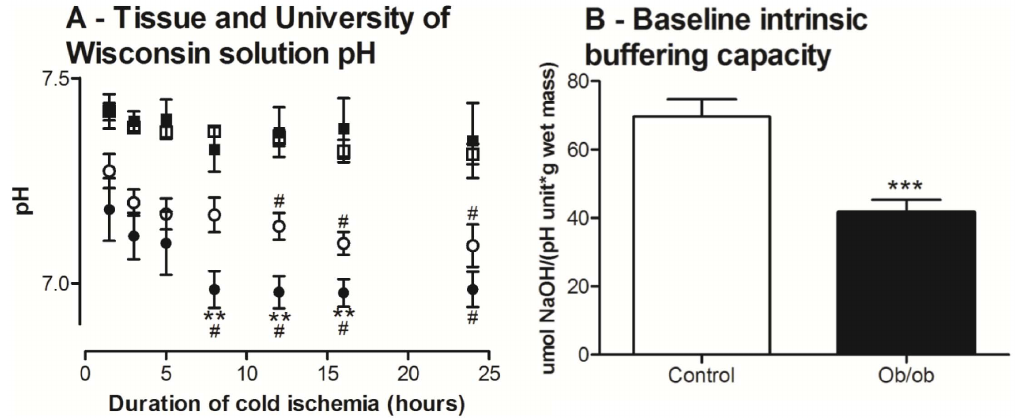
Figure 6. University of Wisconsin (UW) solution and tissue pH of ob/ob and lean livers during cold ischemia; and baseline intrinsic tissue buffering capacity of ob/ob and lean livers. A: UW solution pH ( ob/ob , closed square; lean, open square) remained stable during the whole duration of cold ischemia and did not differ between groups. However, ob/ob livers demonstrated significantly lower tissue pH following 8– 16 hours of cold ischemia compared to lean livers. Ob/ob and lean livers demonstrated decreased tissue pH after 8 and 12 hours of cold ischemia, respectively, relative to 1.5 hours. B: Ob/ob livers also demonstrated significantly lower baseline tissue intrinsic pH buffering capacity. Data are shown as mean 6 SEM (n=9 mice/group; ob/ob , closed circle/bar; lean, open circle/bar). Analyses were performed using two-way ANOVA for tissue pH and un-paired t-test for intrinsic tissue buffering capacity. **, P , 0.01 (vs. lean); ***, P , 0.001 (vs. lean); # , P , 0.01 (vs. 1.5 hours).